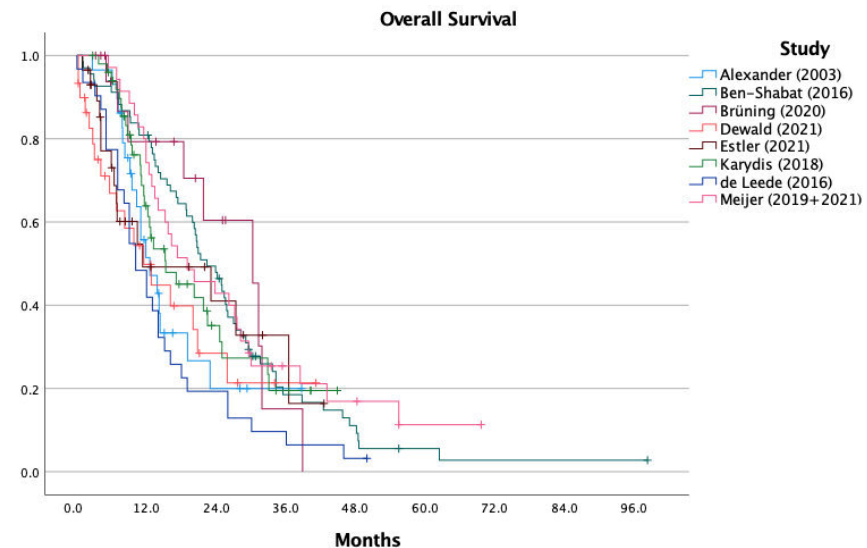
Figure 2. Overall survival per study.